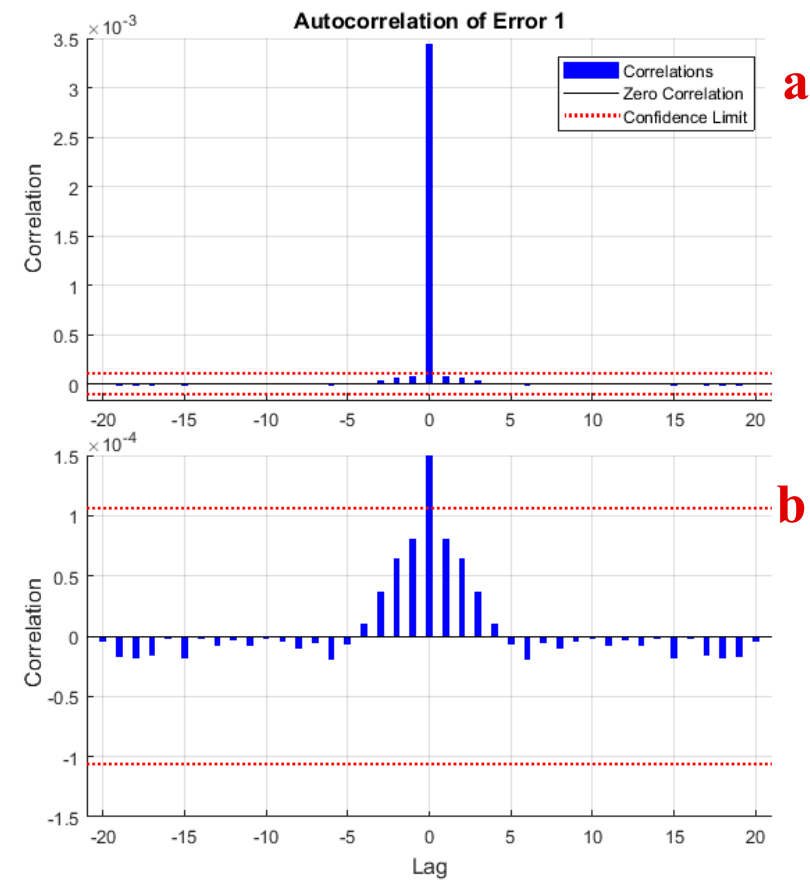
Figure 8. NARX error autocorrelation ( a ) zoom out view ( b ) zoom-in view.